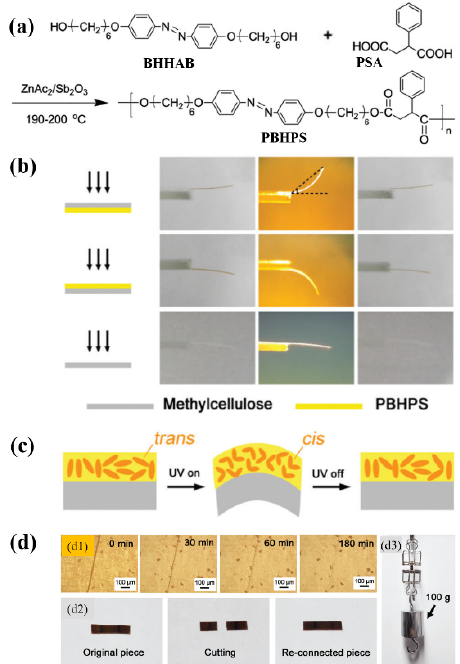
Figure 5. ( a ) Chemical structure and synthetic route of PBHPS. ( b ) Digital pictures of the P 0 . 50 /MC 0 . 50 film motion with the UV light on or off (365 nm, 15 mW cm − 2 ); ( c ) schematic illustration of light-driven deformation and shape recovery of the P/MC film; ( d1–3 ) self-healing process of PBHPS at 60 °C under the POM ( d1 ), digital pictures of the reconnecting process for the broken pieces ( d2 ), and the mechanical strength of the re-connected PBHPS piece with the loading of a 100 g weight ( d3 ). Adapted with permission from Reference [50]. Copyright 2017 Royal Society of